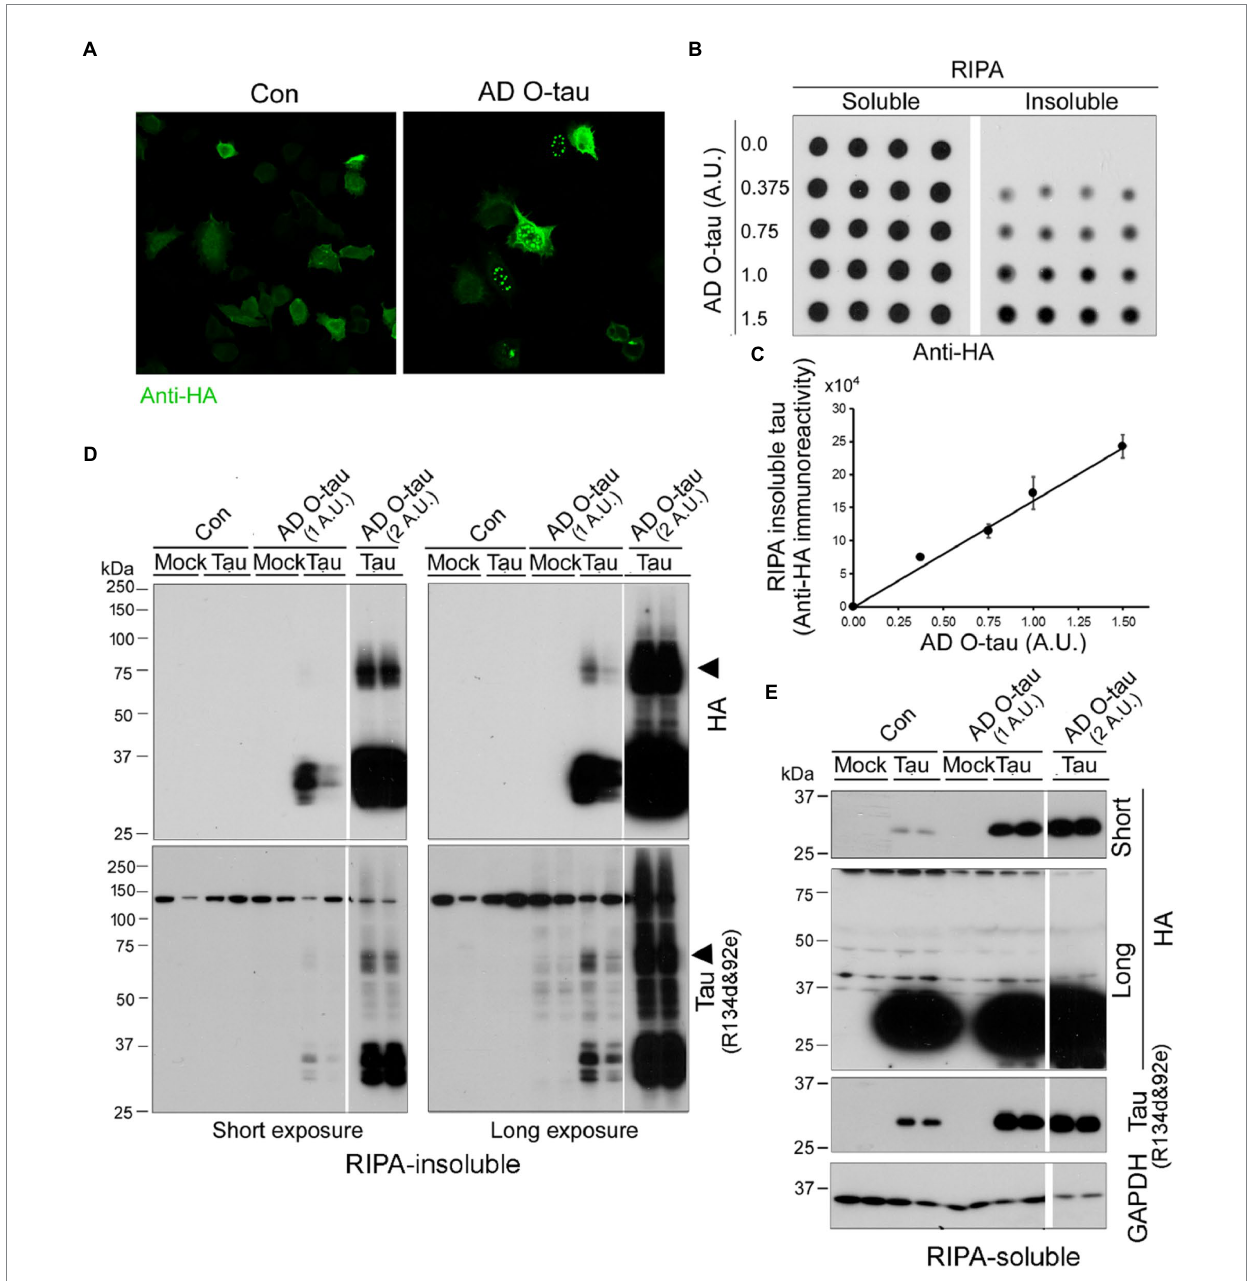
FIGURE 5 AD O-tau induces tau aggregation dose-dependently. (A) AD O-tau seeded tau 151-391 aggregation in cultured HeLa cells. HeLa cells expressing HA- tau 151-391 were treated with AD O-tau and immunostained with anti-HA 42 h after the treatment. (B,C) AD O-tau seeded tau aggregation dose- dependently. HEK-293FT cells expressing HA-tau 151-391 in quadruplicate were treated with various amounts of AD O-tau. RIPA-insoluble and -insoluble taus were analyzed by immuno-dot blots developed with anti-HA (B) 42 h after treatment. RIPA-insoluble tau was plotted against amounts of AD O-tau (C) . (D,E) AD O-tau seeded tau aggregates displayed SDS- and β -ME-resistant high molecular weight tau (HMW-tau) species. HEK-293FT cells expressing HA-tau 151-391 in duplicate were treated with AD O-tau. RIPA-insoluble (D) and -insoluble taus (E) were analyzed by Western blots developed with anti-HA or anti-pan-tau (a mixture of R134d and 92e), non-transfected cells are labeled as mock. Arrowhead indicates the SDS- and β -ME- resistant HMW-tau